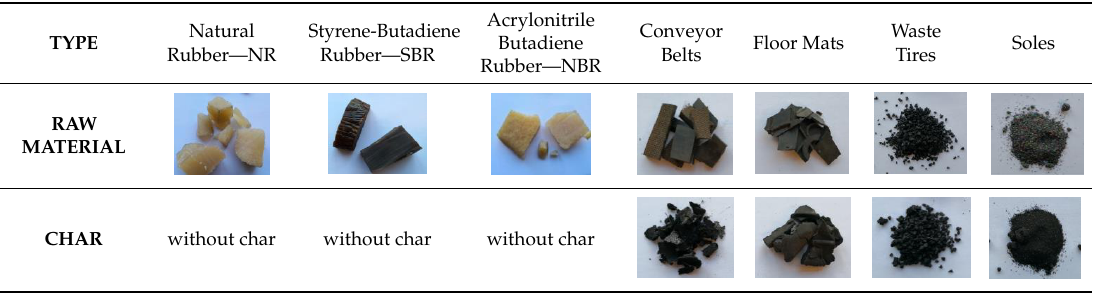
Table 1. Raw materials before and after the pyrolysis process.